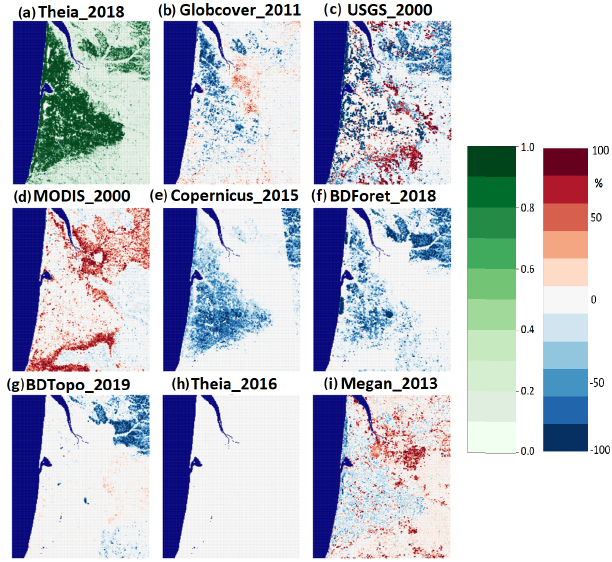
Figure 3. Forest density comparisons for different land cover databases. The name of each database is shown at the top of each image. The forest density is shown for the Theia2018 dataset in (a) ; the rest of the panels show the percentage differences between each database and the Theia2018 dataset. Two scales are provided for the figure. The first scale (shades of green) corresponds to the reference case (a) , and the second scale shows the differences between the reference case and the indicated dataset ( b through i